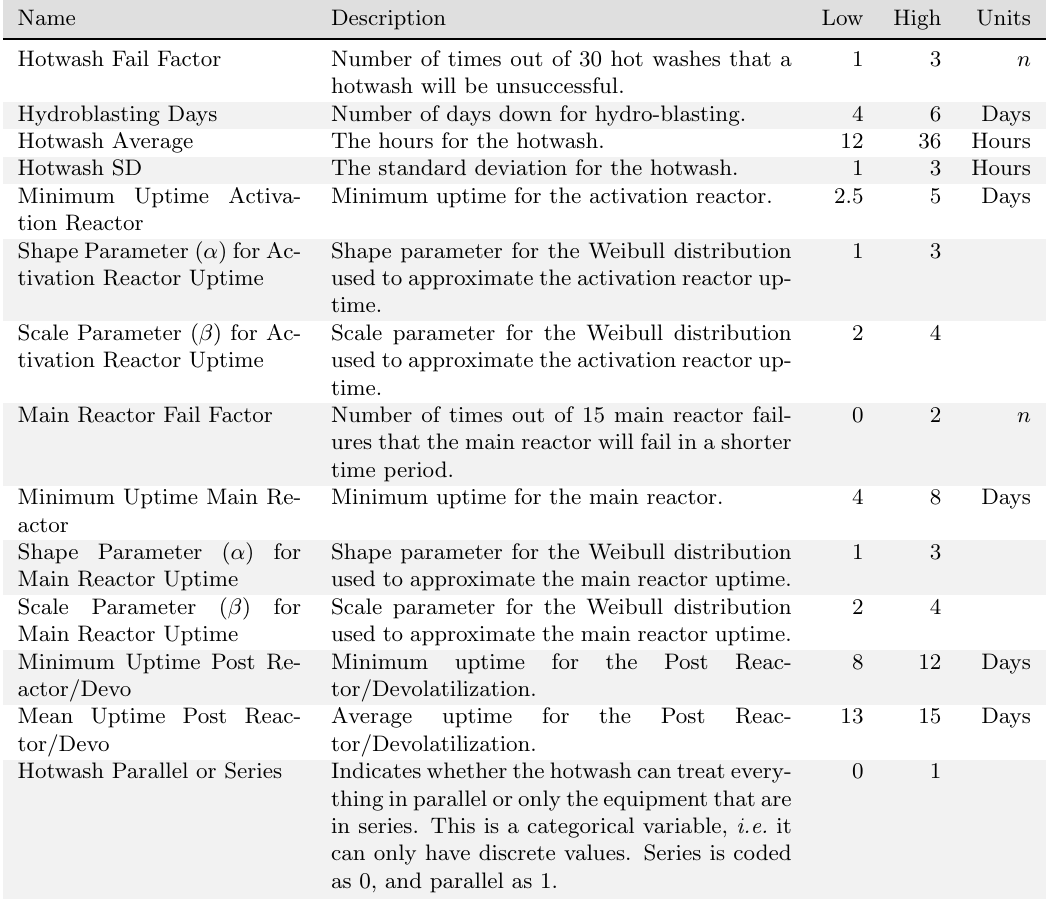
Table 1: Input variables and ranges used in the experimental design